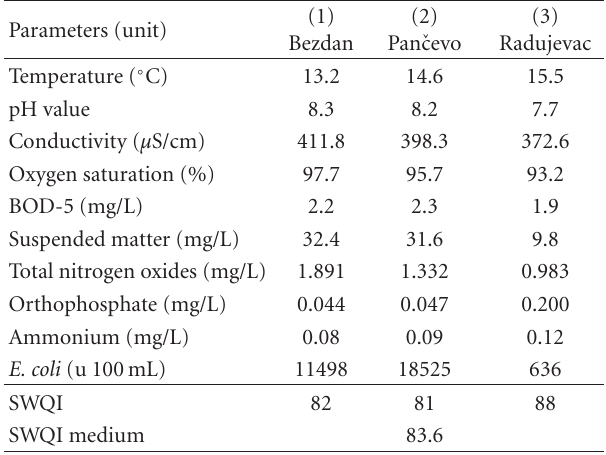
Table 3: SWQI water quality along the River Danube for the